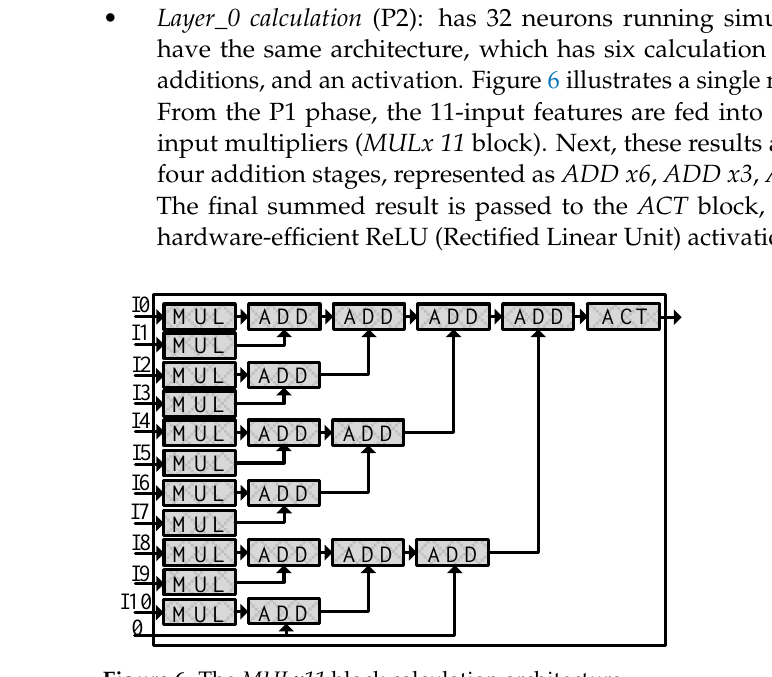
Figure 6. The MULx11 block calculation